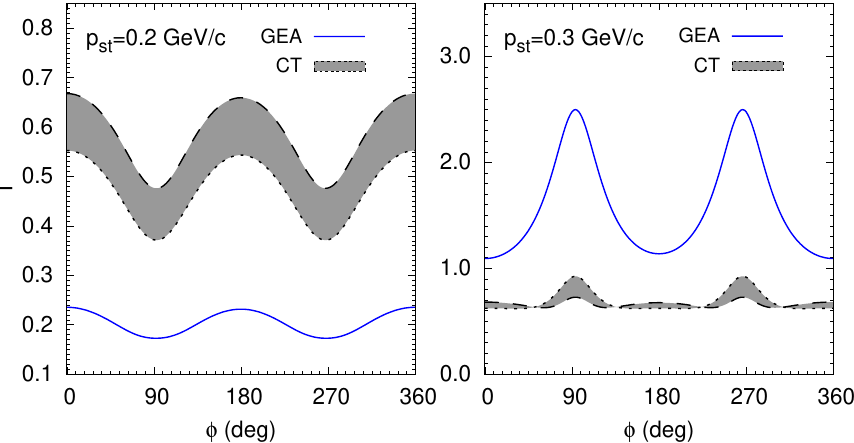
Figure 4. Transparency ratio, Equation (16), for the process ¯ pd 15 GeV/ c , α s = 1, β = 1 as a function of the relative azimuthal angle between π − and the spectator proton for the two different transverse momenta p st of the spectator proton. Notations as in Figure